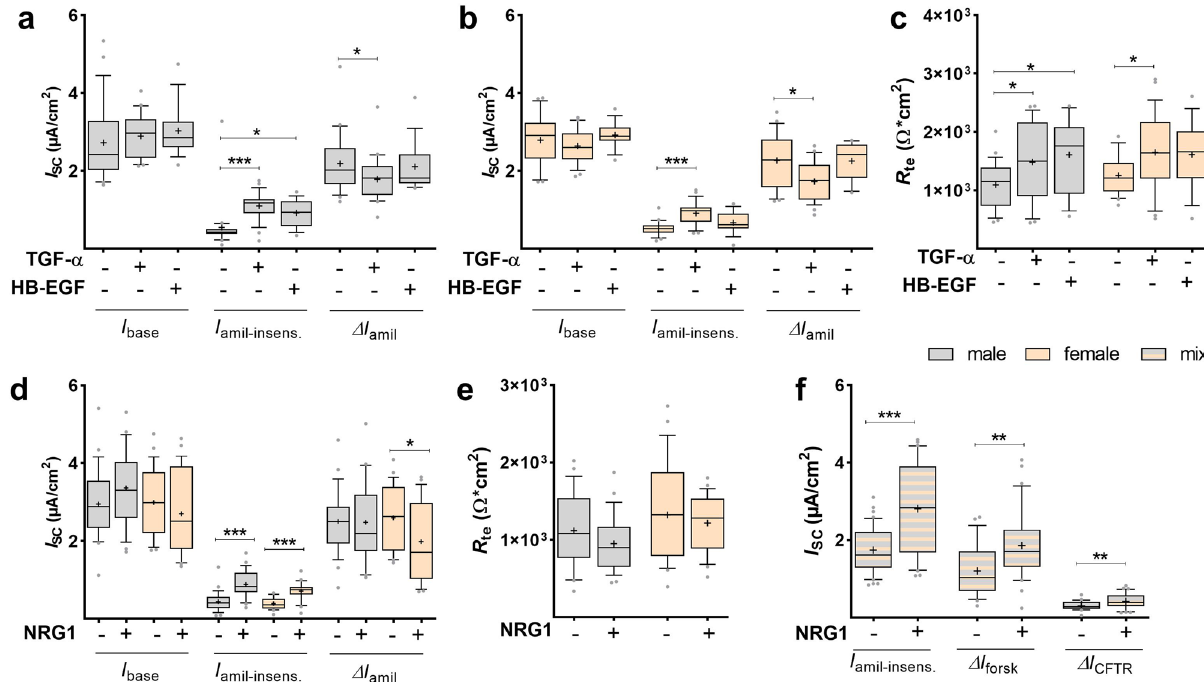
Figure 11. ErbB ligands equally increased amiloride-insensitive I SC in both sexes. FDLE cells were cultured in SF-Med and stimulated with TGF-α, HB-EGF or NRG1 for 24 h. Data are displayed as box and whiskers with the 10–90 percentile, mean (+) and median (horizontal line). TGF-α increased I amil-insens and decreased Δ I amil in male ( a ) and female ( b ) FDLE cells (n = 23–38; *** p < 0.001 by t -test). HB-EGF increased I amil-insens in male cells (n = 15–23; * p < 0.05). ( c ) TGF-α increased R te in male and female cells, and HB-EGF increased R te in male cells, with the same trend observed in females (* p < 0.05). ( d ) NRG1 increased I amil-insens in male and female cells, while NRG1 decreased Δ I amil in female FDLE cells (n = 25–27; * p < 0.05; *** p < 0.001). ( e ) R te was not affected by NRG1 in male and female cells. ( f ) NRG1 increased I amil-insens , Δ I forsk and Δ I CFTR in mixed FDLE cells (n = 39–43; ** p < 0.01; *** p < 0.001). (Grey boxes) male; (yellow boxes) female; (white square)